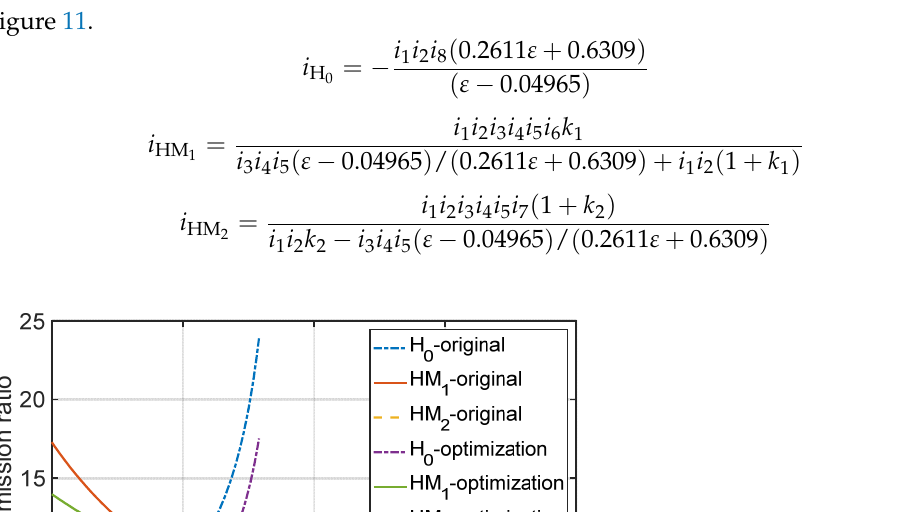
Figure 11. The comparison of speed regulating characteristics of transmission parameters before and after optimization.